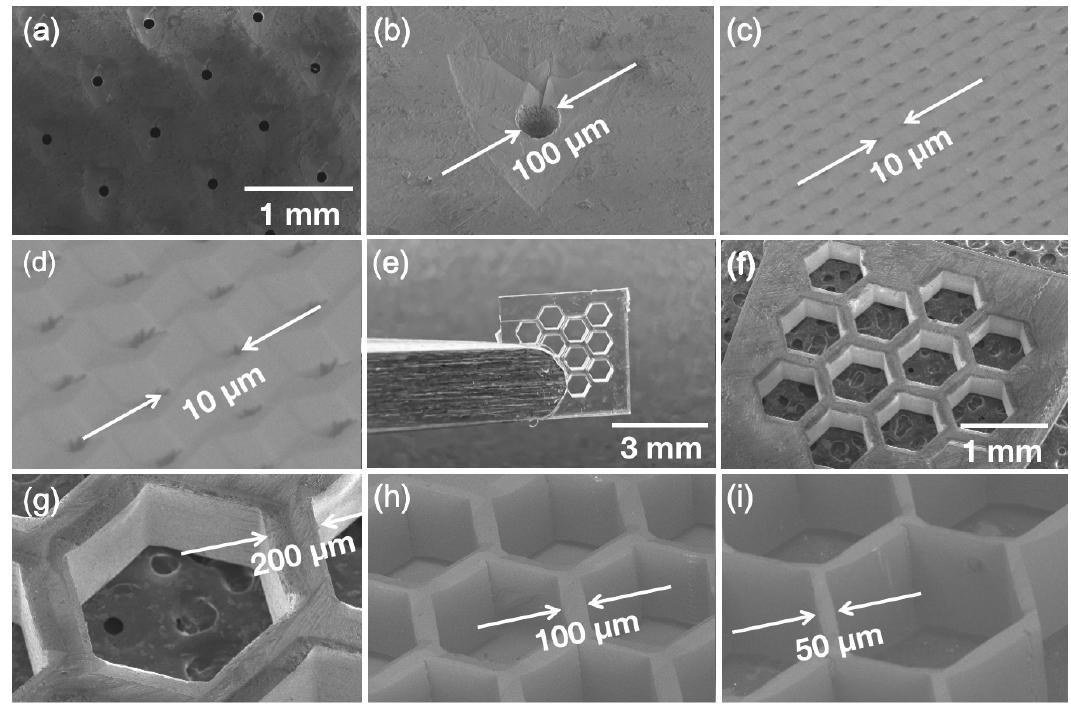
Figure 5. Structures fabricated out of crystalline C-cut sapphire. ( a , b ) 100 µ m diameter hole matrix, ( c , d ) single line 10 µ m pitch hole matrix, ( e – g ) honeycomb structure where the side of the hexagon is 400 µ m, and the walls between hexagon are 200 µ m, ( h , i ) similar hexagon structure with diminished walls between hexagon respectively 100 µ m and 50 µ